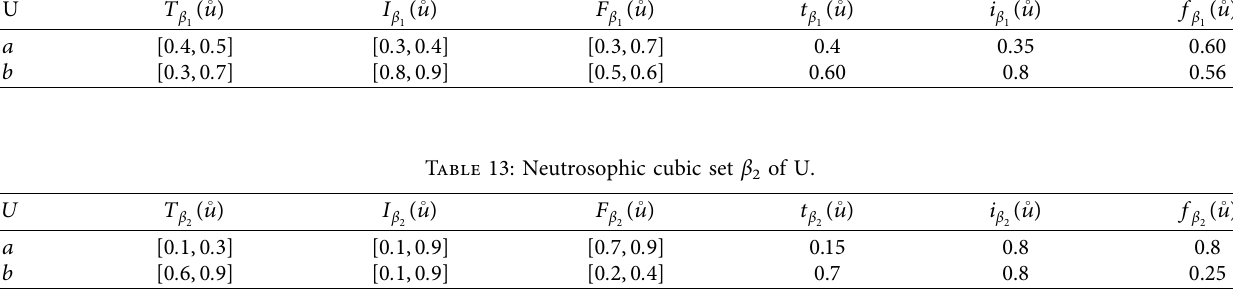
Table 12: Neutrosophic cubic set β